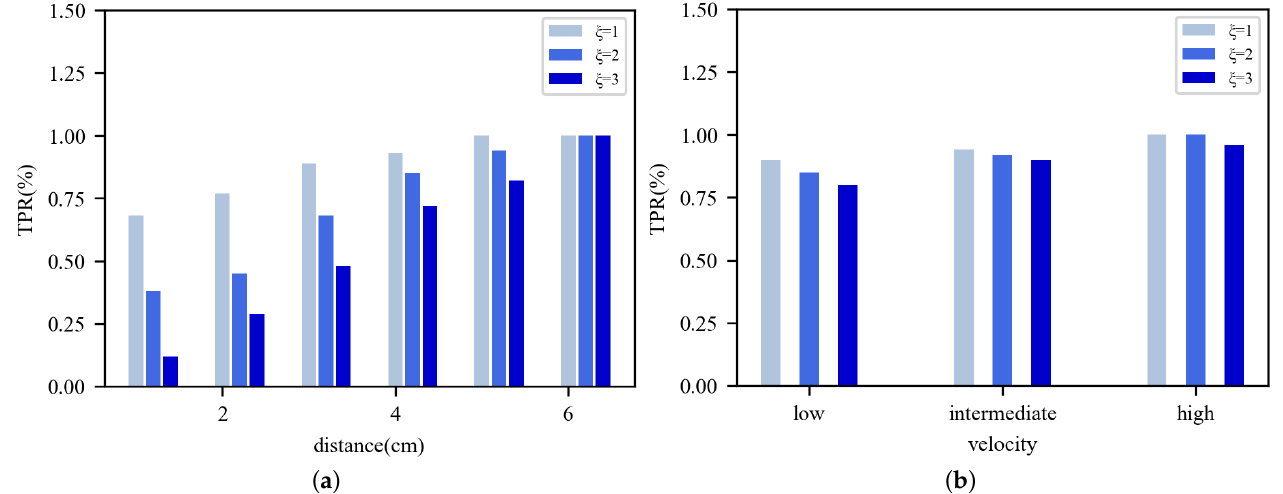
Figure 8. Accuracy when identifying effective nodes by different thresholds. ( a ) Moving. ( b ) Dynamic environments.